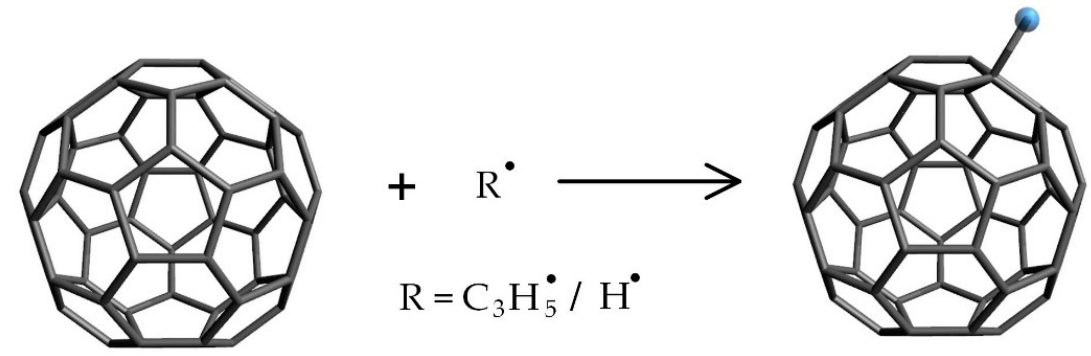
Figure 11. Dissolved gases of vegetable insulating liquid after thermal aging.